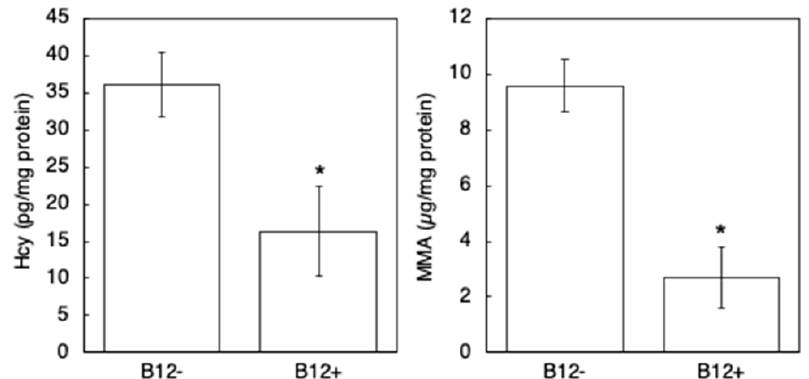
Figure 2. Hcy and MMA levels in B 12 − and B 12+ N2 worms. Hcy and MMA levels were measured as described in the Materials and Methods section. All values represent the mean ± SD of three independent experiments (n = 3). Asterisks indicate significant differences compared to the B 12 − worms (* p < 0.05).